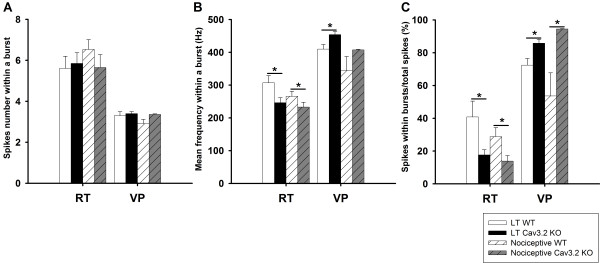
Comparison of burst firing properties of LT and nociceptive RT and VP units in WT and Cav3.2 KO mice. The white and black bars represent the values for the LT units and the slashed bars those of the nociceptive units. (A) Average number of spikes in a burst, (B) mean firing frequency within a burst, and (C) percentage of spikes within bursts were compared between the WT and the KO groups. *: p < 0.05 by t-test of WT and KO comparison